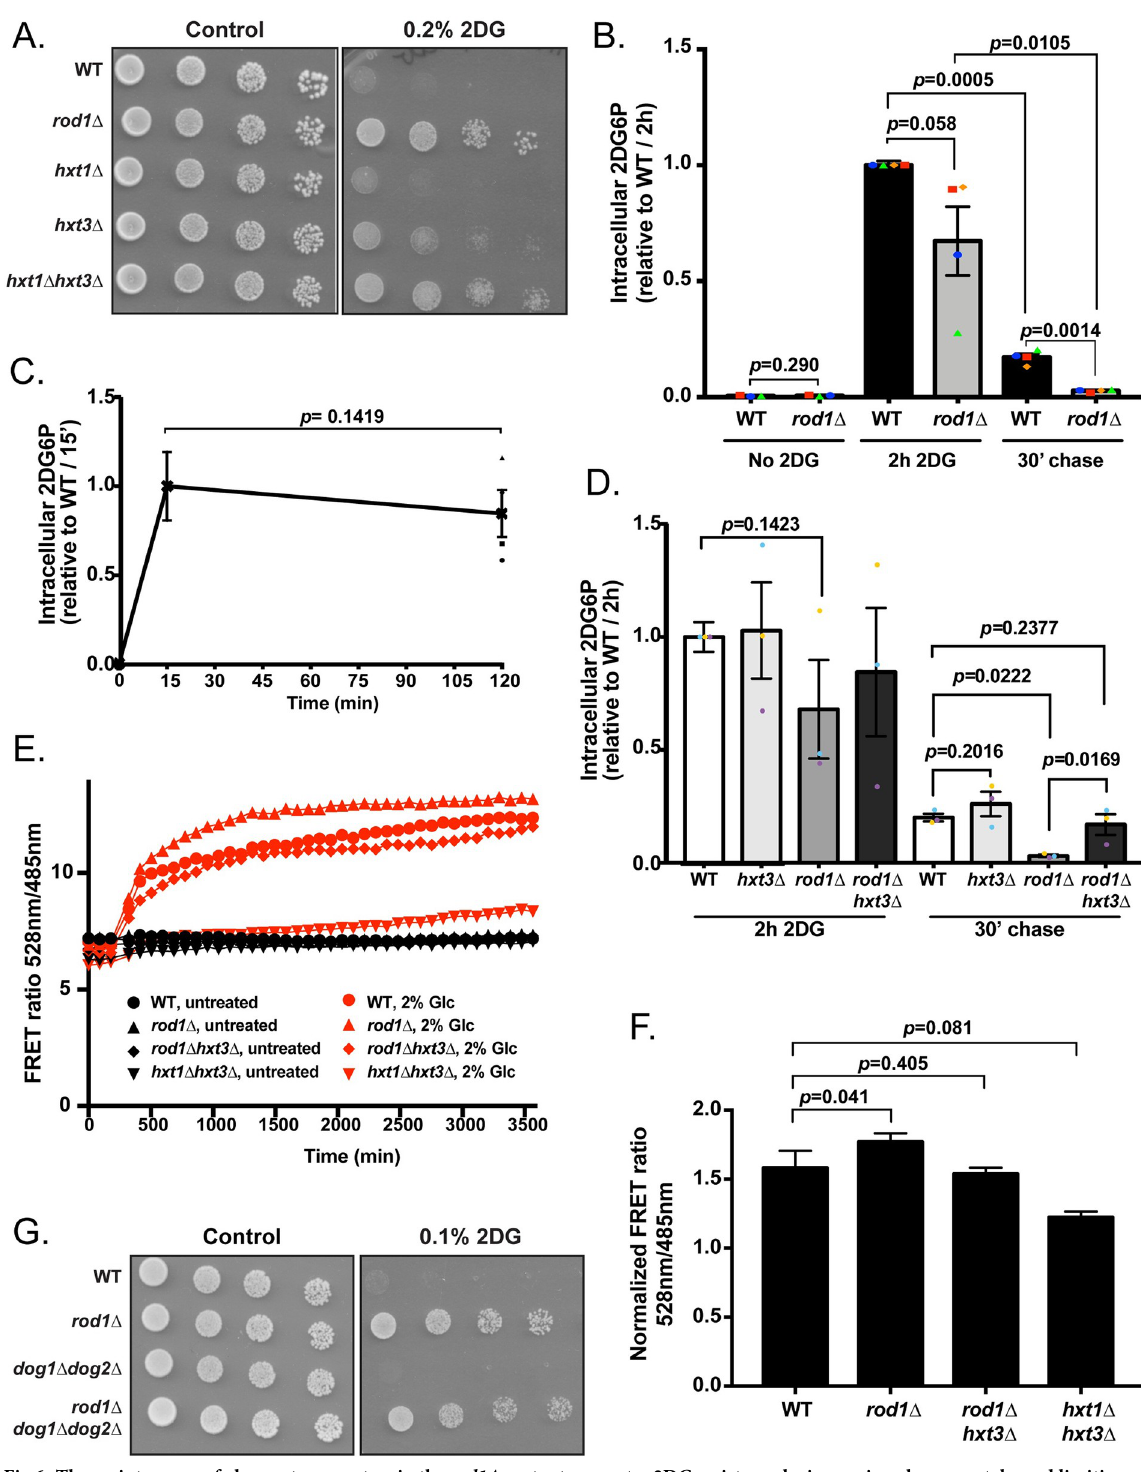
Fig 6. The maintenance of glucose transporters in the rod1 Δ mutant promotes 2DG resistance by increasing glucose uptake and limiting 2DG toxicity. ( A ) Serial dilutions of cultures of the indicated strains were spotted on SC medium or SC + 0.2% 2DG medium and grown for 4 days at 30˚C. ( B ) Intracellular 2DG6P was assayed enzymatically in WT and rod1 Δ cells grown overnight in a glucose-containing medium, treated for 2h with 0.2% 2DG, and then transferred into a 2DG-free glucose-containing medium (“chase”). Values are normalized to the value of the WT / 2h (n = 4 independent experiments ± SEM, paired t -test, p -value indicated). ( C ) 2DG6P content was assayed from WT cells as in ( B )